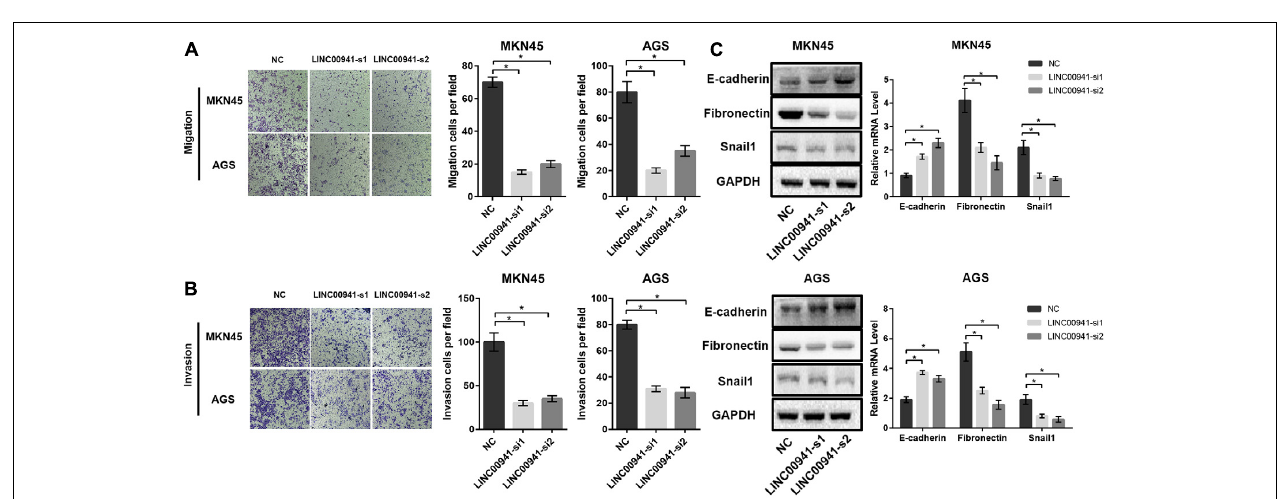
FIGURE 4 | Silence of LINC00941 inhibits GC cells migration and invasion in vitro . (A) Silence of LINC00941 inhibits the migration abilities of MKN45 and AGS cells. (B) Silence of LINC00941 inhibits the invasive ability of MKN45 and AGS. (C) The expression of E-cadherin, Fibronectin, and Snail1 in MKN45 and AGS cells was assessed by western blot and qRT-PCR. GAPDH was used as a loading control. The expression was normalized to GAPDH . Two-tailed Student’s t -test was used to analyze the significant differences, ∗ p < 0.05.